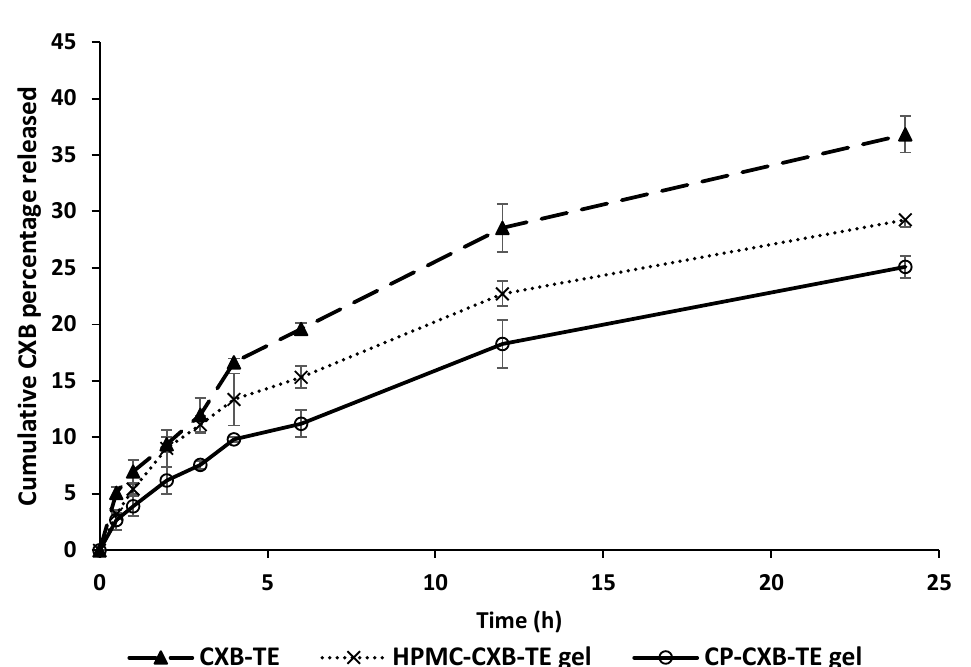
Figure 4. In vitro release profile of CXB-transethosomes (CXB-TES) formulation compared to CXB transethosomes-loaded HPMC-based hydrogel (HPMC-CXB-TES gel), and CXB transethosomes- loaded Carbopol-934-based hydrogel (CP-CXB-TES gel), in phosphate buffer (pH 6.8, 1% w/v SLS) at 37 ± 0.5° C. Data are expressed as mean ± S.D. ( n = 3).